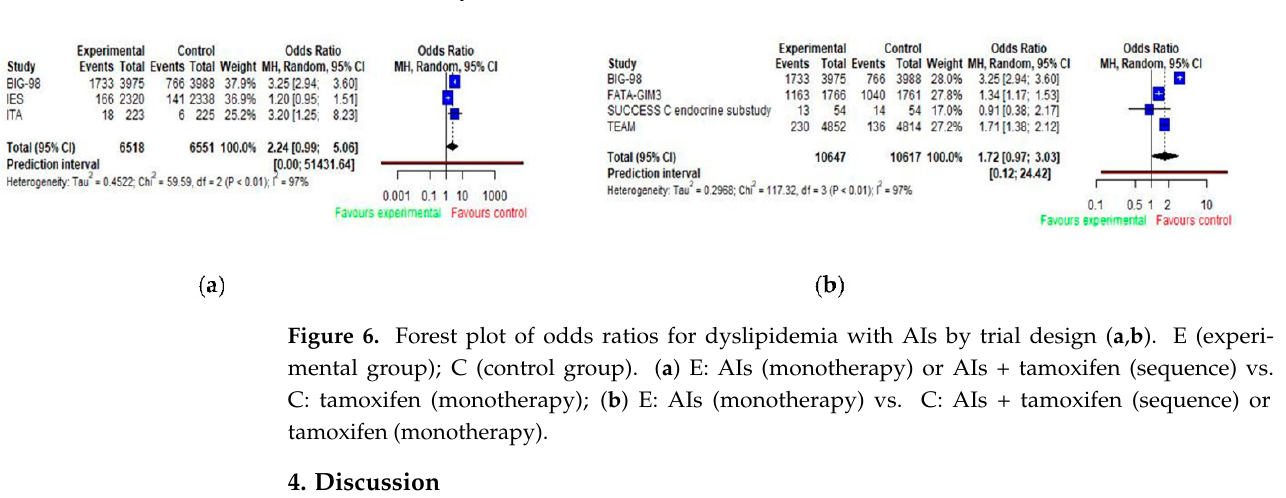
10 of 15 Figure 5. Forest plot of odds ratios for body weight gain with AIs by trial design ( a,b ). E (experimental group); C (control group). ( a ) E: AIs vs. C: tamoxifen (in monotherapy); ( b ) E: AIs (monotherapy) vs. C: AIs + tamoxifen (sequence) or tamoxifen (monotherapy). 3.5. Dyslipidemia In our study we defined dyslipidemia as all lipid disorders, such as hyperlipidemia,